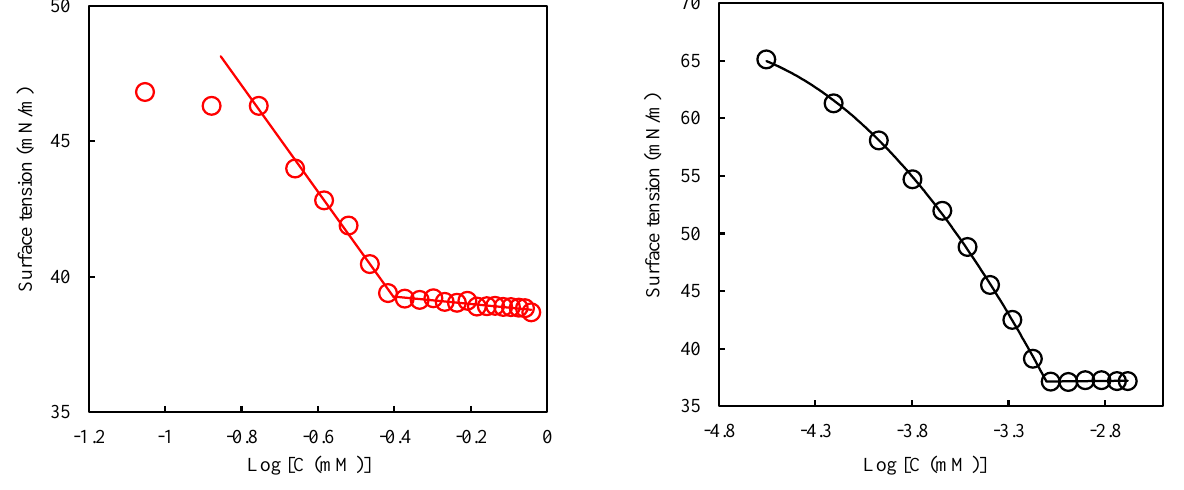
Figure 4. Surface tension versus logarithm of concentration for C 16 mimBr ( left ) and CTAB ( right ) at 25 ◦ C. Table 4. Parameters obtained from the surface tension data at 25 ◦